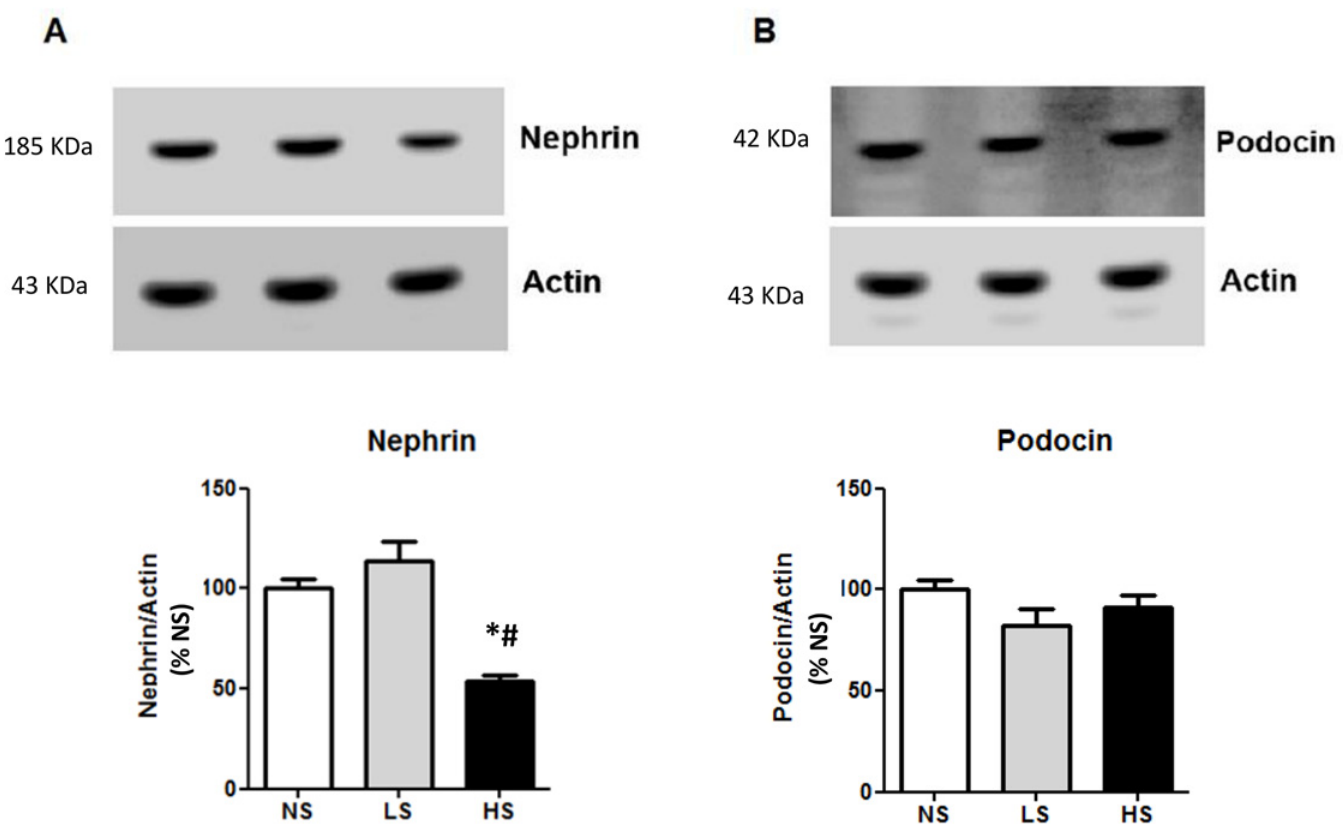
Fig 3. Analysis of nephrin and podocin renal protein expression. (A) Nephrin. (B) Podocin. Data are means ± SEM. NS: normal salt diet. LS: low salt diet. HS: high salt diet. * P < 0.05 vs. NS; # P < 0.05 vs LS. (N = 6 /